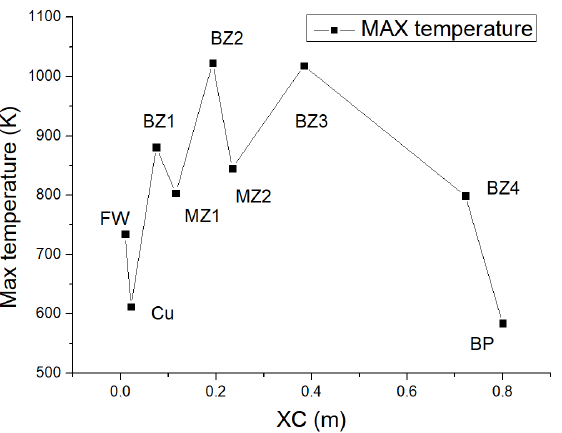
Figure 10. The maximum temperature distribution on the XC direction of the optimized model.